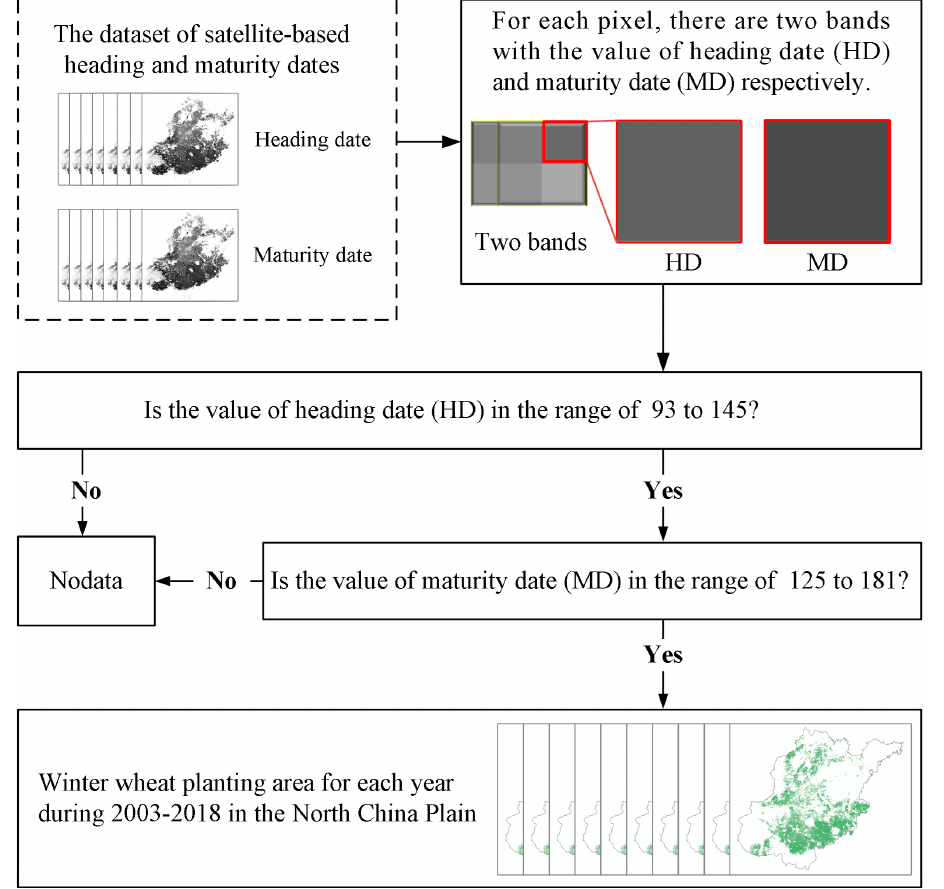
Figure 2. The decision tree for extracting the winter wheat planting area each year in the North China